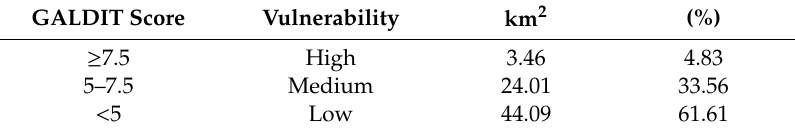
Figure 3. GALDIT vulnerability map of the aquifer system in the study area. Table 3. Distribution of the vulnerability class areas (%) according to